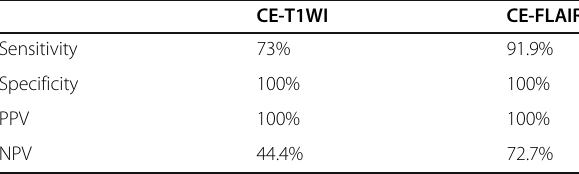
Table 2 Results of MR in total cases ( n = 45). CSF analysis was considered the gold standard (37 cases were positive and 8 cases were